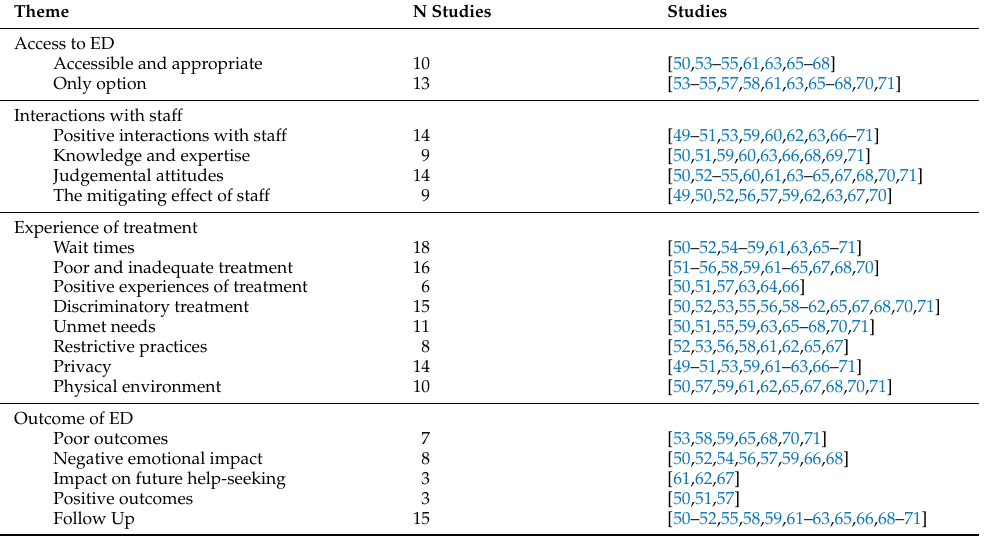
Table 2. Major and subthemes, and the studies in which they